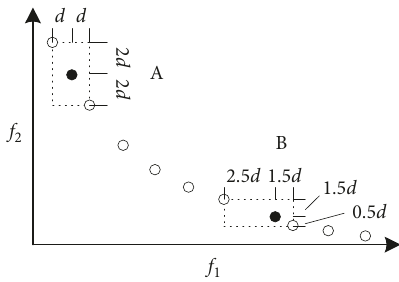
Figure 1: The method of space density estimating.